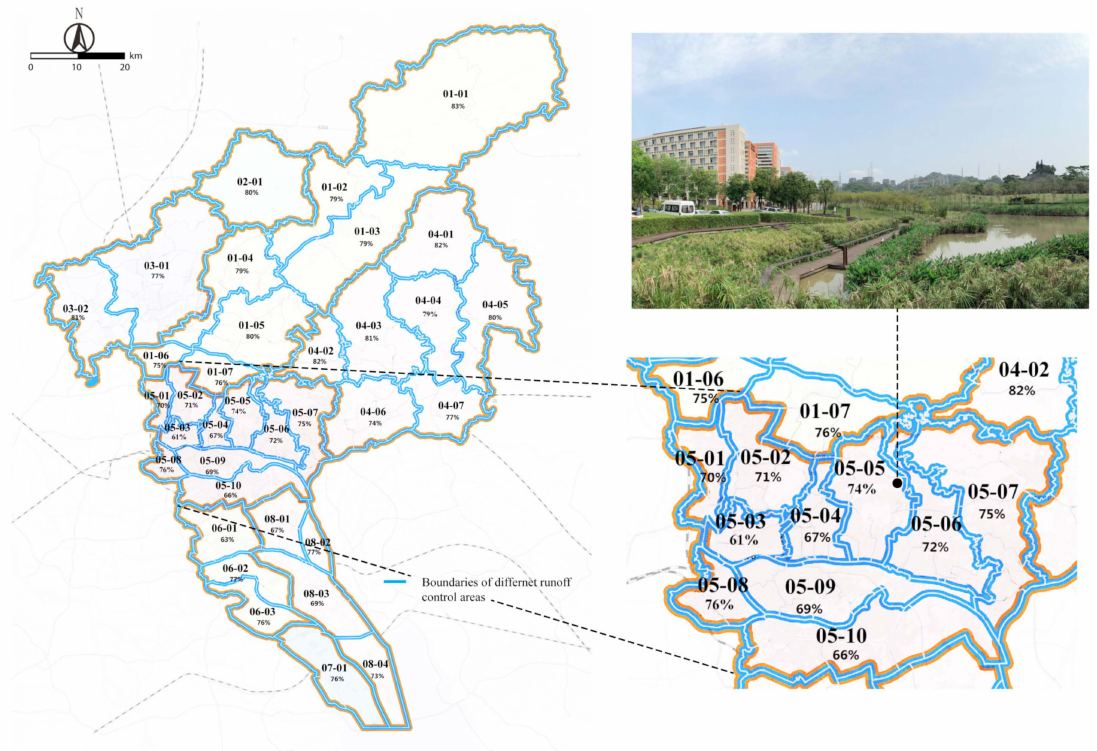
Figure 4. Run‑off control regulatory codes for flood resilience and Daguan Wetland Park in Tianhe District under the Guangzhou Sponge City Program, based on the Guangzhou Sponge City Plan 2010–2030